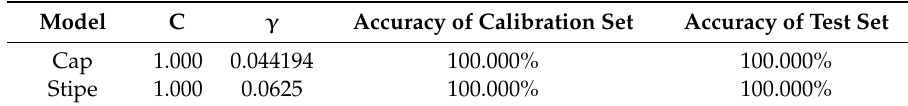
Table 3. Results of GS-SVM